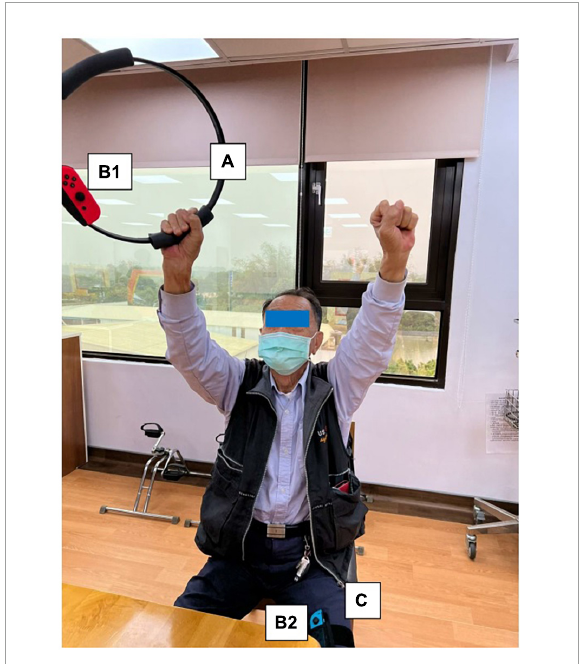
FIGURE2 Components of Nintendo Switch. To play the RingFit Adventure, the player needs to use the Nintendo Switch, which includes the following devices: A. Ring-Con: A Pilates ring the user holds; B. Joy-Con: A wireless controller. One of the Joy-Con (B1) should be placed on the Ring-Con (A). The other Joy-Con (B2) should be affixed to a Leg Strap (C) on the thigh of the